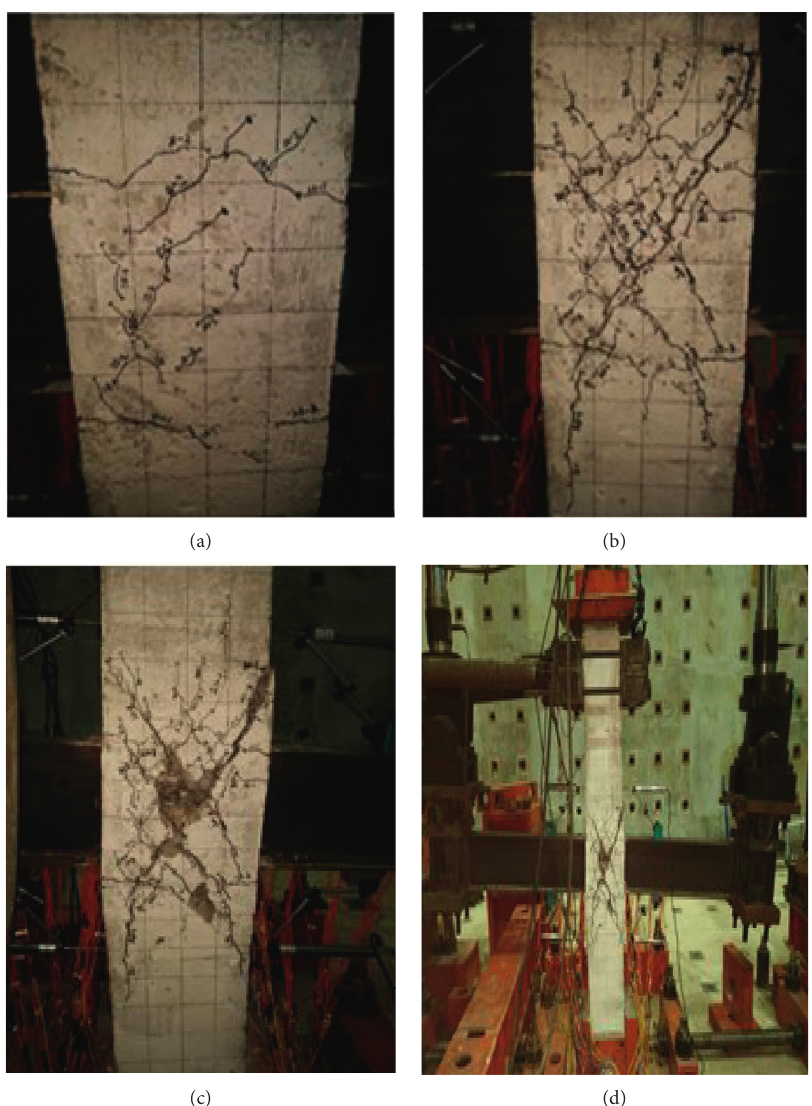
Figure 6: Failure modes of SRC-1. (a) Crack at yield capacity. (b) Crack development. (c) Final cracks. (d) Overall specimen at failure.